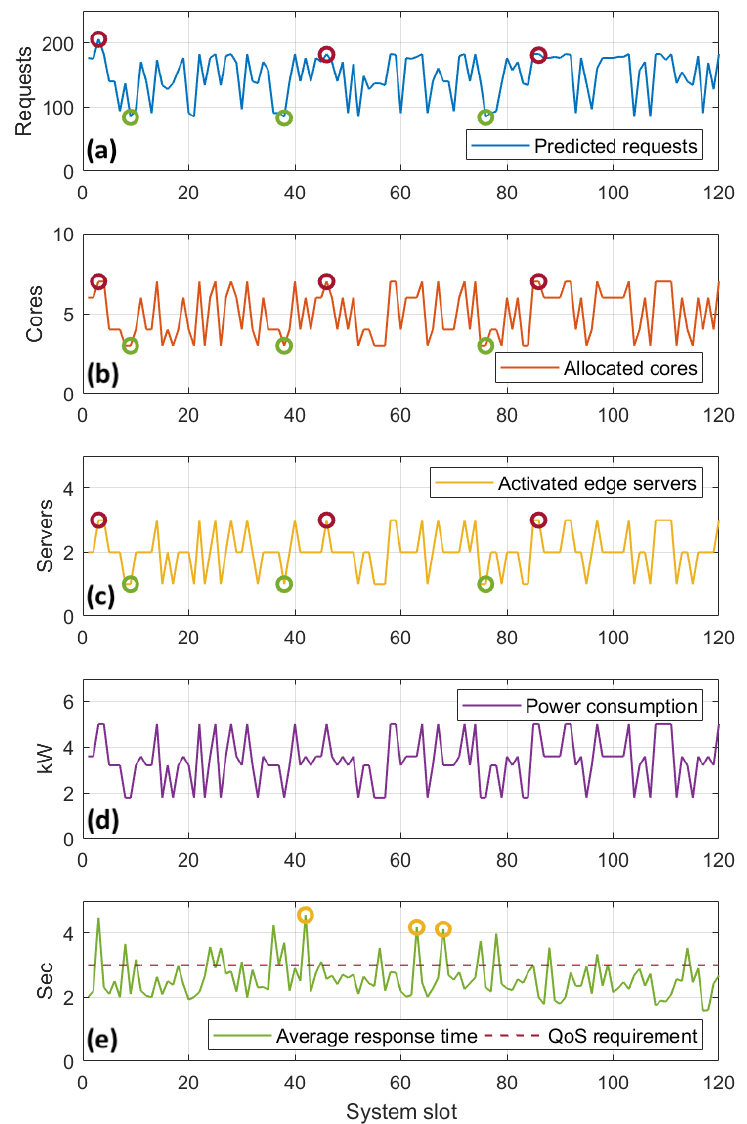
Figure 7. Dynamic resource allocation: Allocated cores ( b ), number of activated edge servers ( c ), power consumption ( d ) and ART ( e ) as a response to the number of predicted requests ( a ), for a single